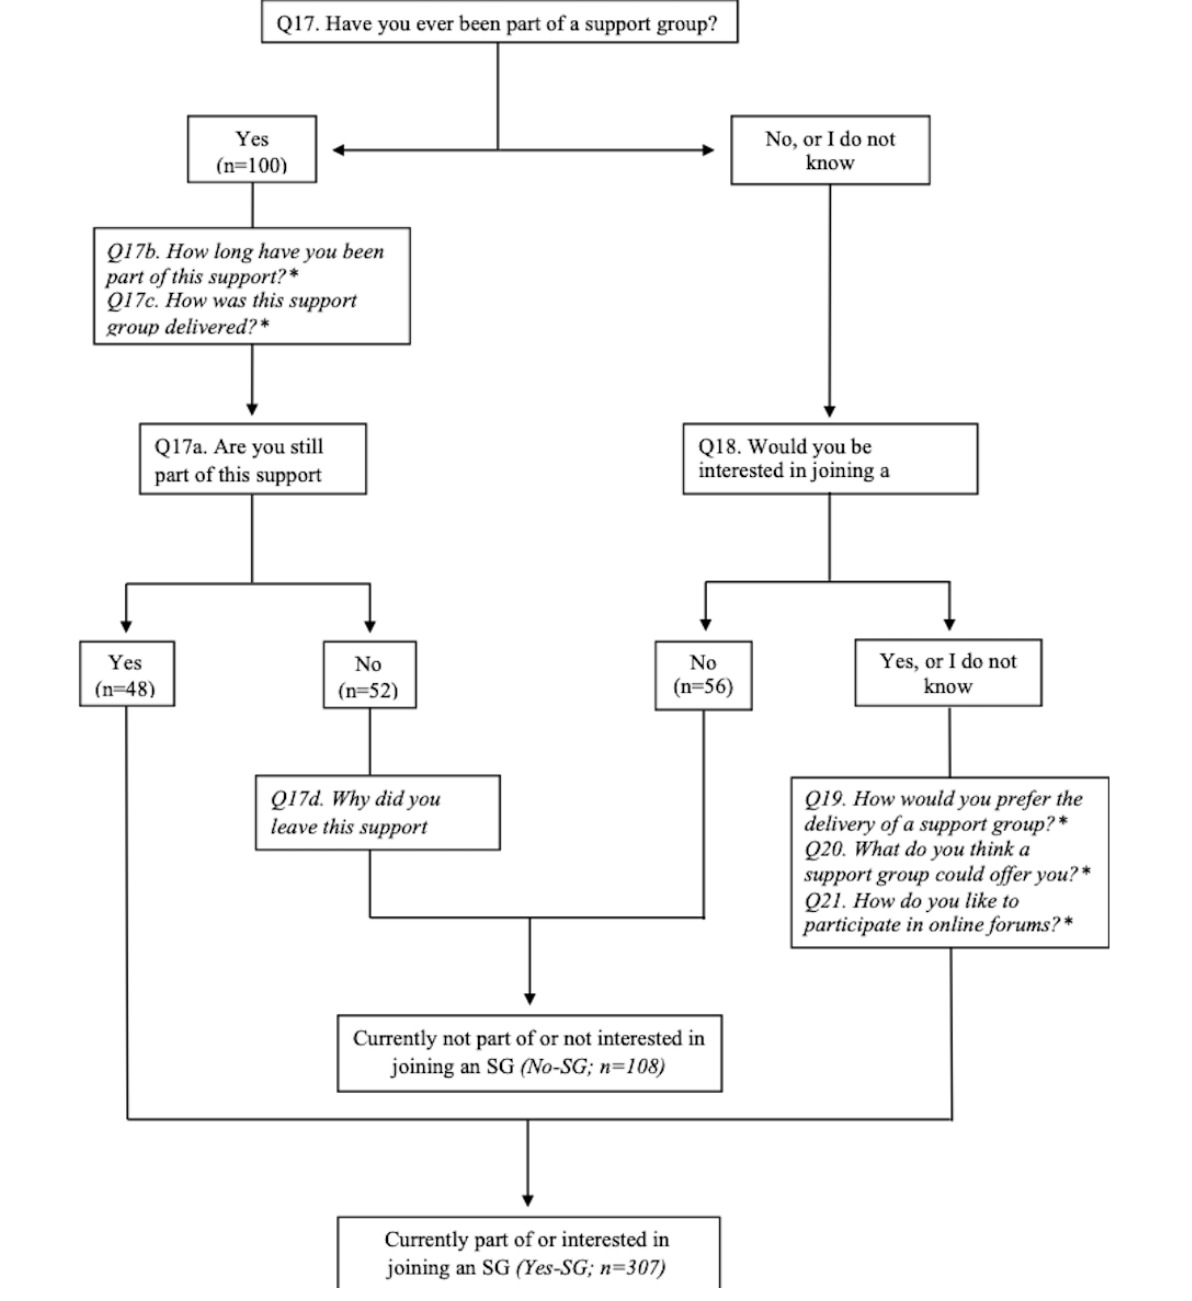
Figure 1. Flowchart of questions for classifying respondents into Yes-SG and No-SG. Logic questions included in the survey that were not used for classification are specified with an asterisk. Q: question; SG: support